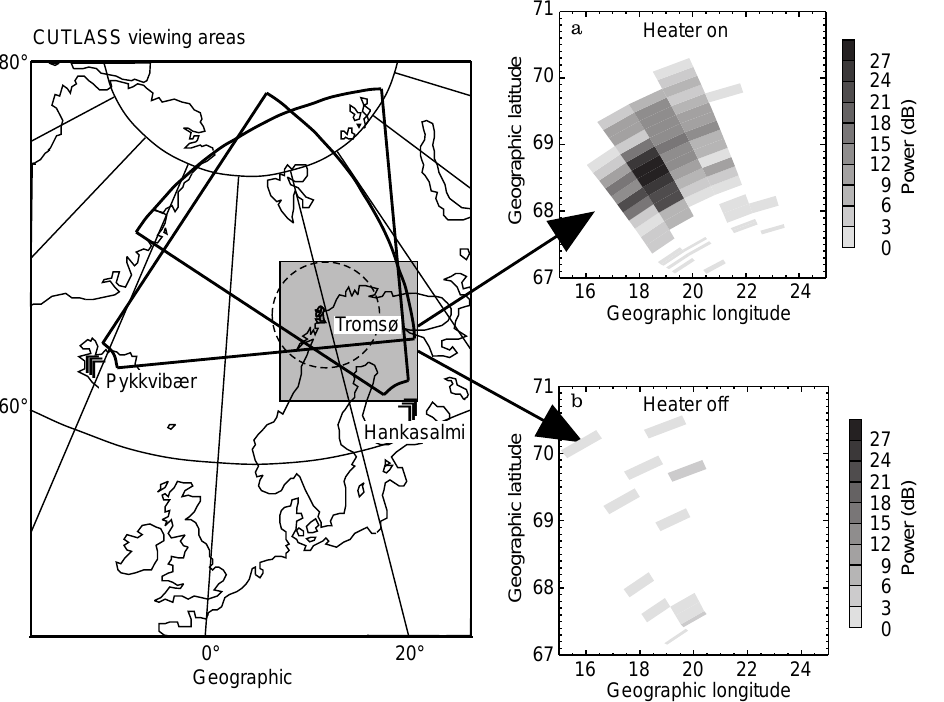
Fig. 2a, b. The map on the left depicts the locations and fields-of- view of the CUTLASS and EI- SCAT radars. The shaded region indicates the area covered by the spatial plots presented in a and b . a Returned power from the CUTLASS Finland radar on 26 April 1996, during a heater-on period. b Data taken 4min later during a heater